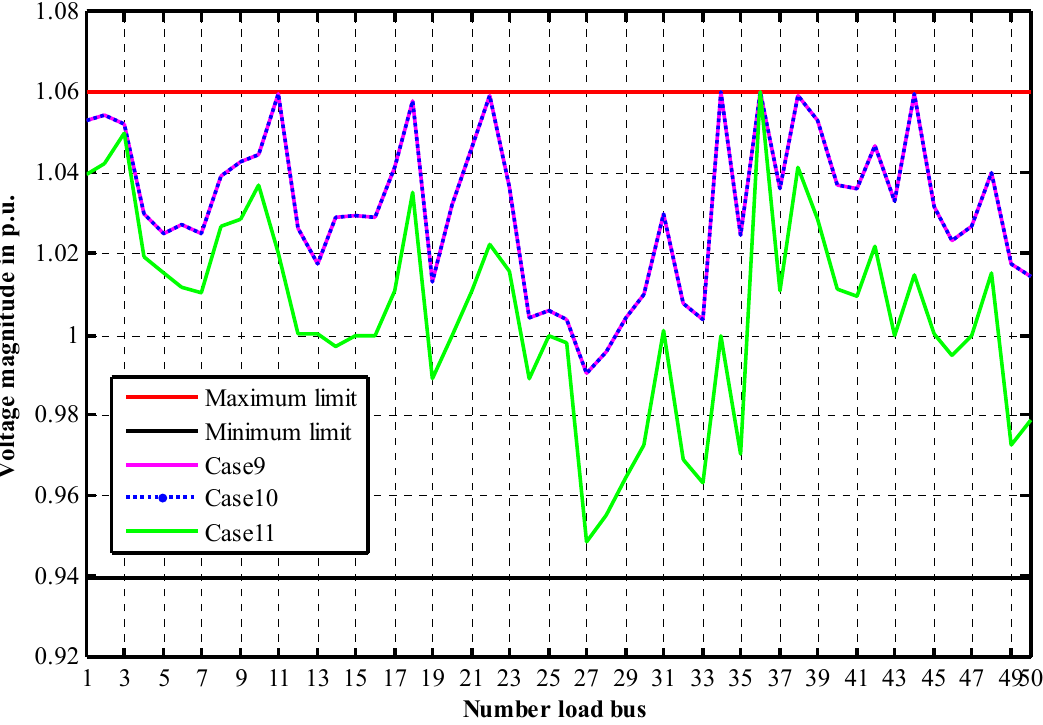
Figure 5. The voltage profile of the Cases 9 to 11.